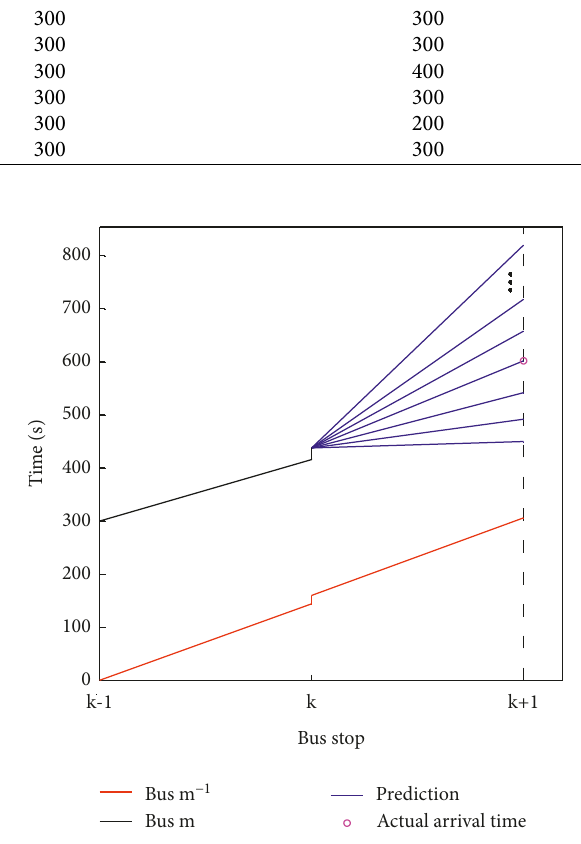
Figure 7: Individual prediction